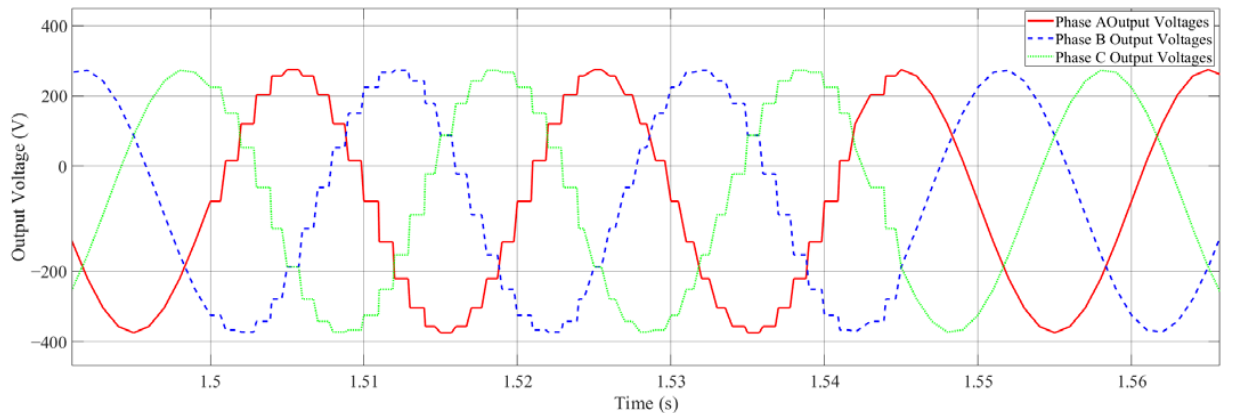
Figure 18. Output voltage zoomed view in ABC frame during solar radiations variations.